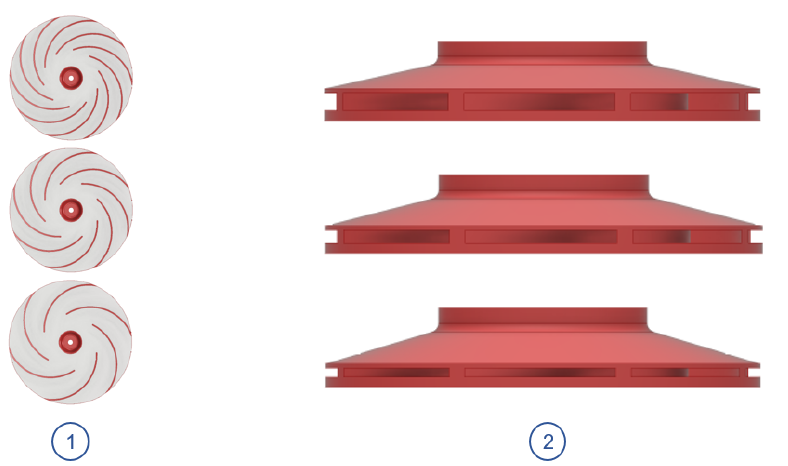
Figure 11. Impeller geometric parameters sensitivity analysis: ( 1 ) number of blades. ( 2 ) Outlet